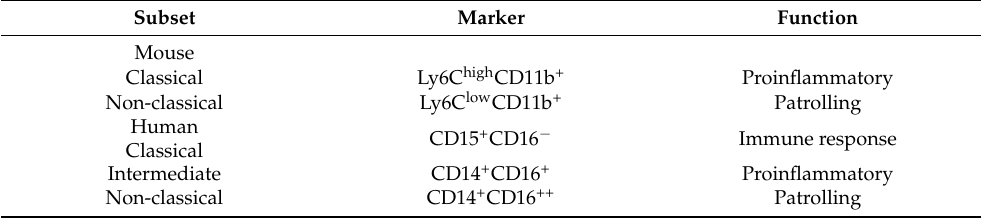
Table 1. Mouse and human monocyte subsets . Mouse and human monocyte subsets enlisted with their primary markers and function according to Sprangers et al.